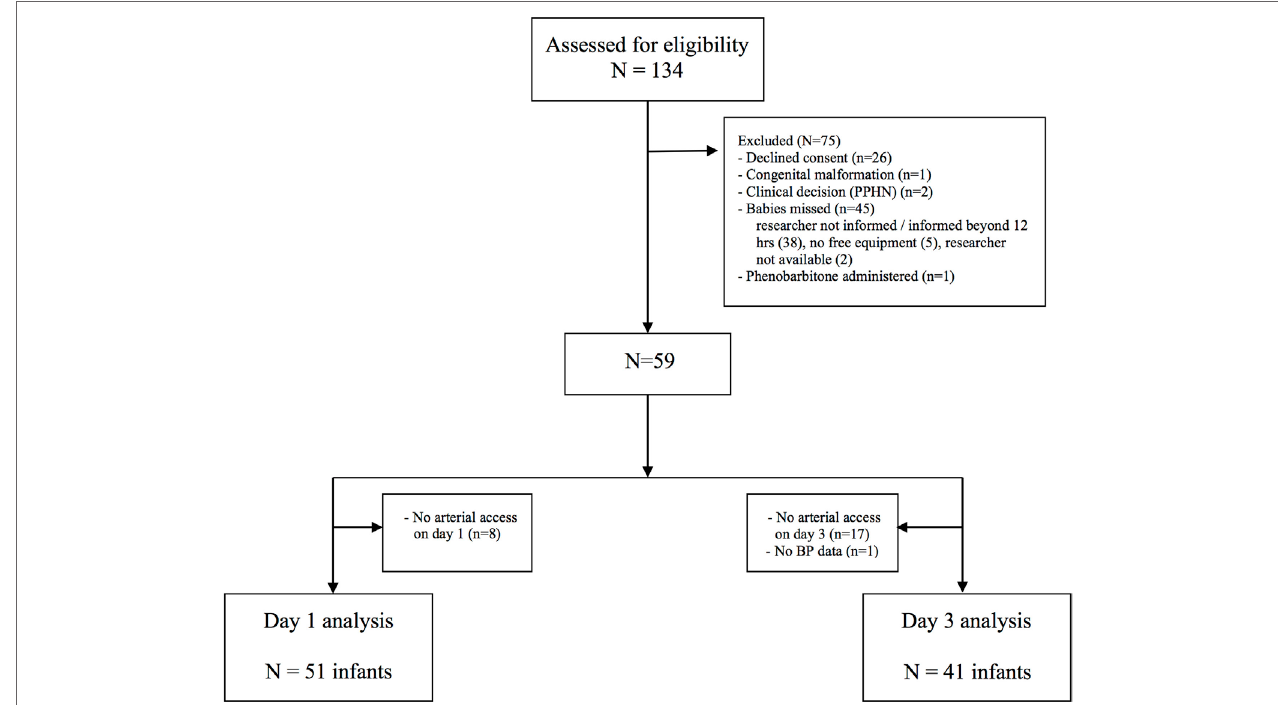
FigUre 1 | CONSORT diagram of recruitment of preterm newborns to the